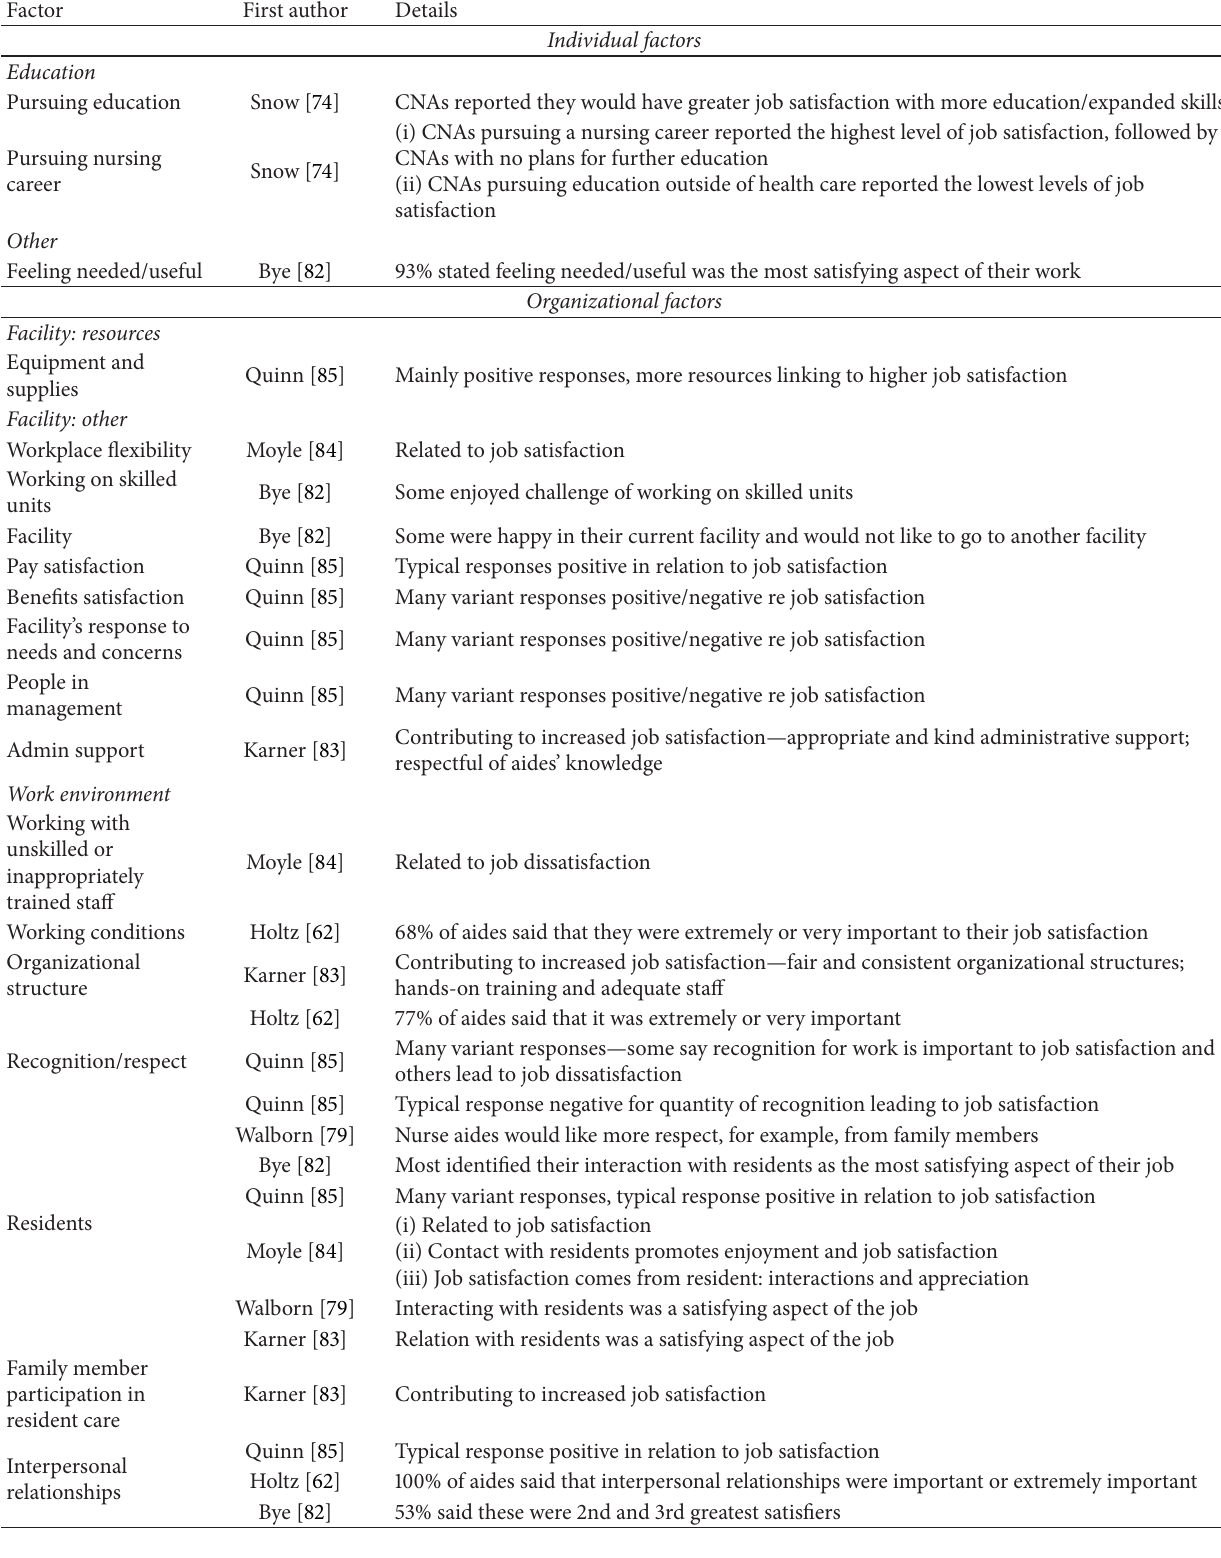
Table 7: Summary of qualitative